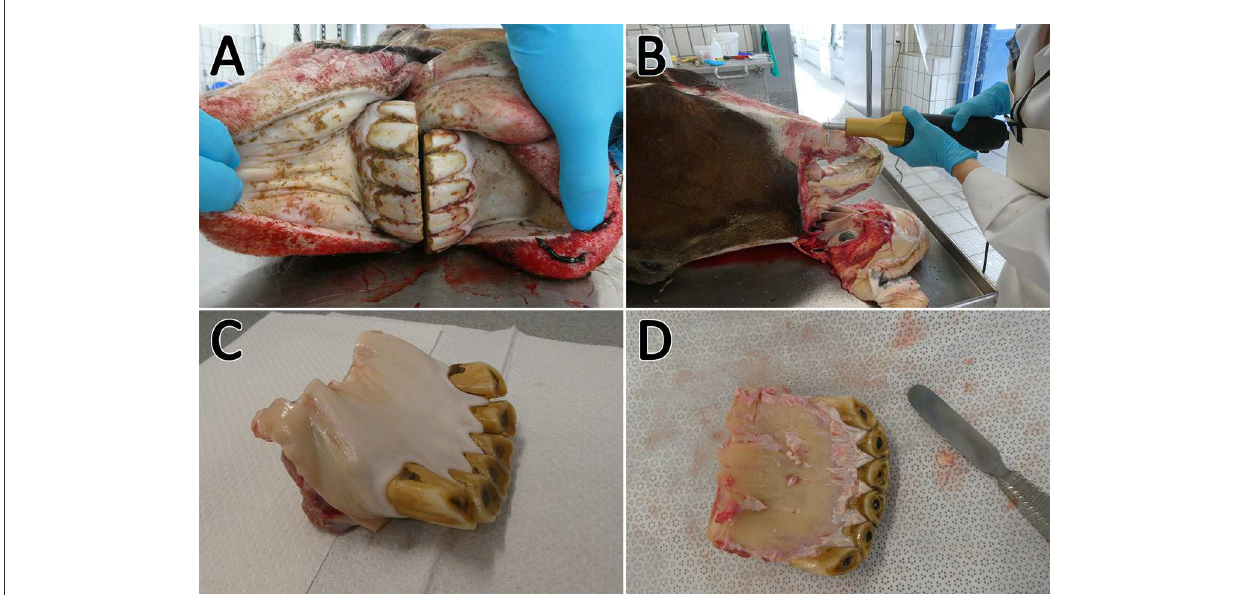
FIGURE1 Sampling procedure. The incisors (A) were cleaned, the soft tissue was removed, and the arcades were dissected (B) . Afterwards the sample could be separated (C) and the remaining soft tissue was removed (D) . Subsequently, the sample was transferred to a microband saw.